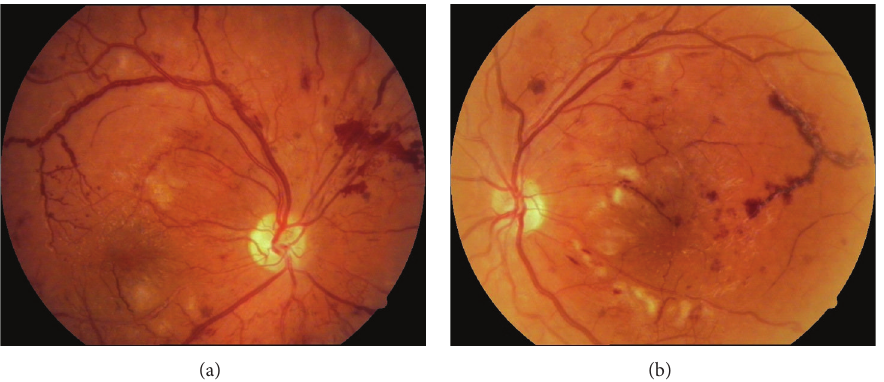
Figure 3: (a) Right eye, color fundus picture taken 45 days after the first presentation showing venous beading, soft-exudates, preretinal hemorrhage and retinal neovascularization. (b) Left eye, color fundus picture showing progression of the vaso-occlusive retinopathy characterized with occlusive vasculitis, widespread cotton-wool exudates and retinal hemorrhages.